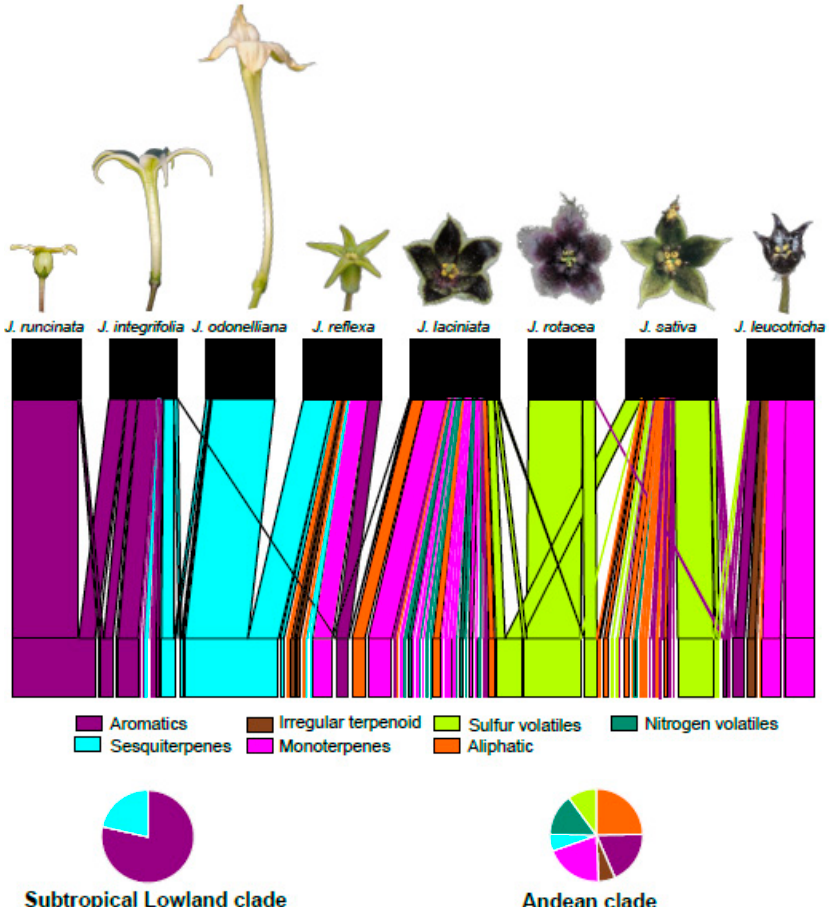
Figure 2. Floral Volatile Organic Compounds (VOCs) emitted by the studied Jaborosa species. Plant –floral volatile network showing the plant species (upper rectangles) connected to emitted floral VOCs (bottom rectangles). Bar widths correspond to the relative percentage of VOCs, i.e., all compounds present in the floral scent of a given Jaborosa species add up 100%. Colors show different chemical classes. Floral VOCs are listed in Supplementary Table S3.